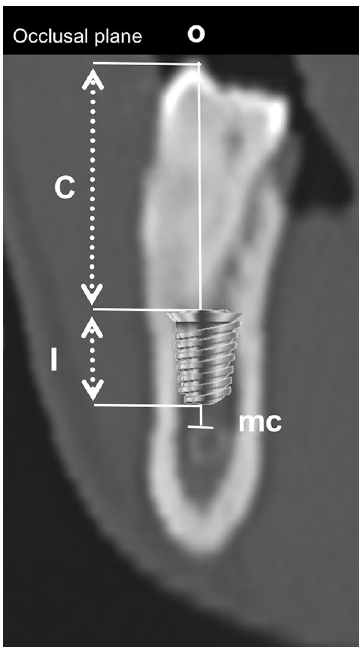
Figure 3. Hypothetical short dental implant placed 1.5 mm coronally to mc, and consequent clinical crown length calculation assuming the occlusal plane remains in the same position as in the dentulous